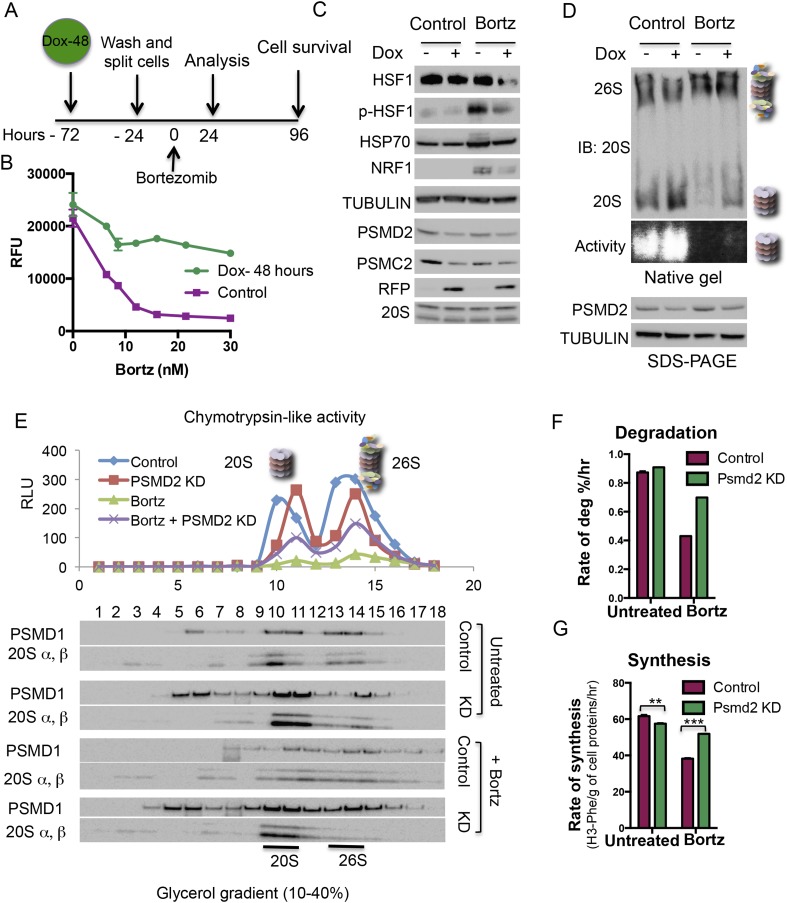
Transient induction of PSMD2 shRNA is sufficient to promote resistance to proteasome inhibition.(A) Schematic representation of the experimental design. (B) T47D cells harboring a doxycycline-inducible PSMD2 shRNA were grown in the presence or absence of 1 μg/ml doxycycline for 48 hr. Cells were then collected, washed, and plated in the absence of doxycycline for 24 hr prior to exposure to increasing concentrations of bortezomib. Relative cell numbers were measured 3 days later. (C) Protein content analysis by immunoblot for the indicated proteins on lysates from control or cells pre-treated for 48 hr with doxycycline (Dox), followed by a recovery of 24 hr and then incubation with 10 nM bortezomib for an additional 24 hr. (D) Native gel analysis of proteasome complexes in cells pre-treated as in (C). The proteasome complex levels and activity of the 20S proteasome were assessed by native gel electrophoresis. Loading controls were analyzed by immunoblot for PSMD2 and tubulin following SDS-PAGE. (E) Glycerol gradient fractionation (10–40%) was conducted on cells pre-treated for 48 hr with doxycycline (Dox), followed by a recovery of 24 hr and then incubation with 15 nM bortezomib for an additional 24 hr. Proteasome activity in the fractions collected was assessed with proteasome-Glo and proteasome content was analyzed by immunoblotting with PSMD1 and 20S subunits specific antibodies. (F) The rate of degradation was analyzed in cells with reduced levels of PSMD2 (green bars) vs control (red bars) in the presence or absence of 10 nM bortezomib (treatment for 20 hr) by monitoring the release of H3-Phe in pre-labeled cells. (G) Rate of total protein synthesis was determined in cells with reduced levels of PSMD2 (green bars) vs control (red bars) in the presence or absence of 10 nM bortezomib (treatment for 20 hr) by measuring the rate of incorporation of 3H-phenylalanine for 1 hr. The p-values were obtained by conducting a two-tailed unpaired t-test. **p < 0.01, ***p < 0.001.